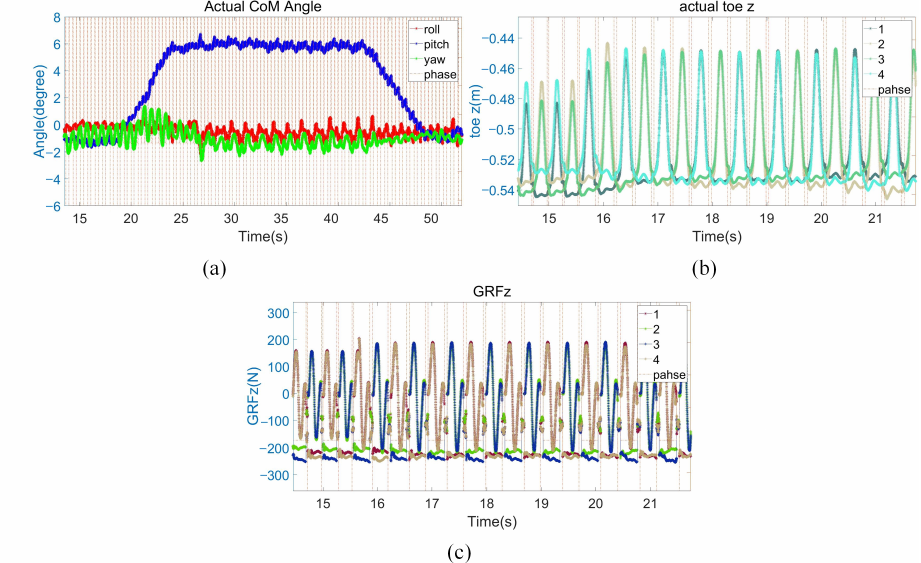
Figure 12. Slight slope experiment data. ( a ) Robot body angle. The red, blue, and green lines present the robot body roll, pitch, and yaw angles; ( b ) the z-direction position of the foot end of the four legs; ( c ) GRF in the z direction.